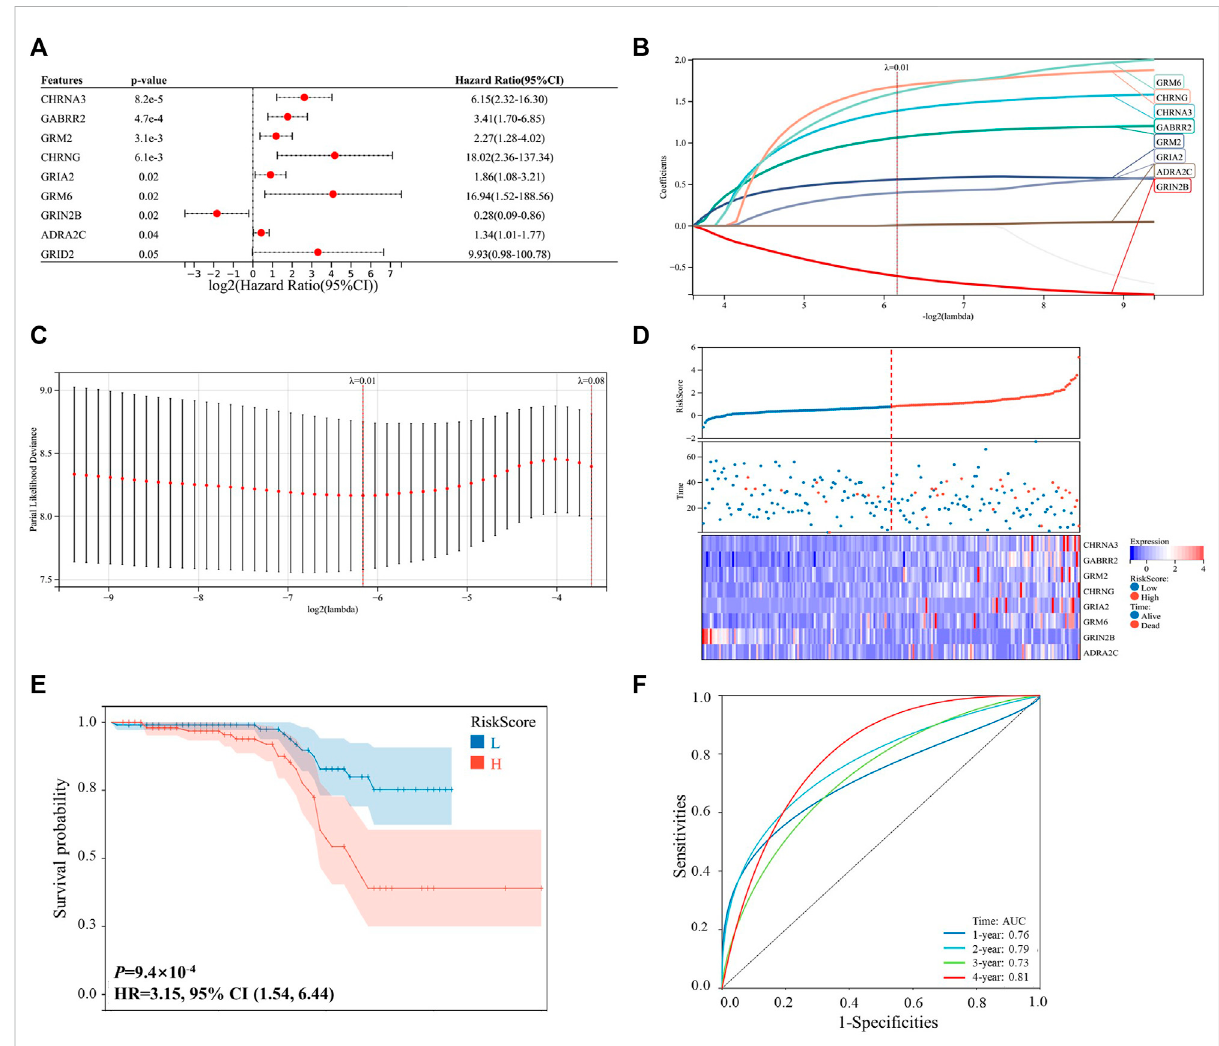
FIGURE 2 Prognosis construction model based on the neurotransmitter receptor-related genes in the ICGC-LIRI-JP dataset. (A) Univariable cox survival analysis of the 115 neurotransmitter receptor-related genes, and nine genes were signi fi cantly correlated with the prognosis of patients with HCC. (B,C) LASSOregressionmodelconstructionbasedontheninepredictivegenesintheICGC-LIRI-JP dataset,and8genesweresuccessfullyincluded in the model. (D) Distribution of the risk scores, survival status, and expression of the eight critically predictive genes. (E) The Kaplan – Meier analysis of overall survival in the high-risk scores group and low-risk scores group. (F) The ROC analysis to evaluate the predictive of risk scores ef fi ciency. CI, con fi dence interval; HCC, hepatocellular carcinoma; ROC, receiver operator